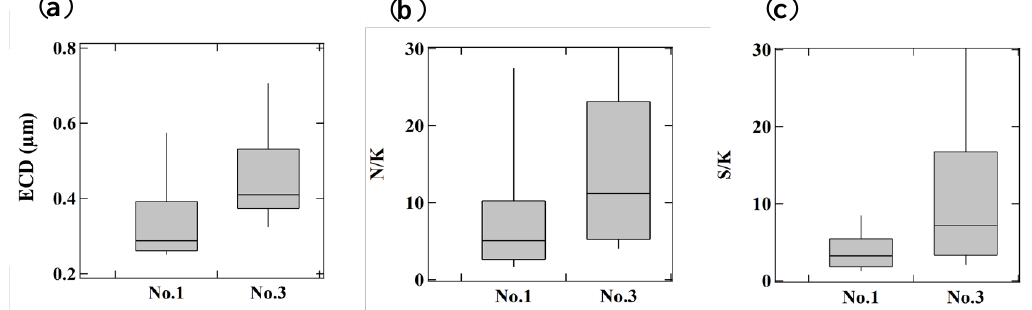
Figure 6. ( a ) The equivalent circle diameter (ECD) of TBs in each sample. ( b , c ) The relative mass ratios of N, and S to K in the TBs, respectively. The top, upper box line, black middle box line, lower box line, and bottom denote values of 90%, 75%, 50% (median), 25%, and 10%, respectively.